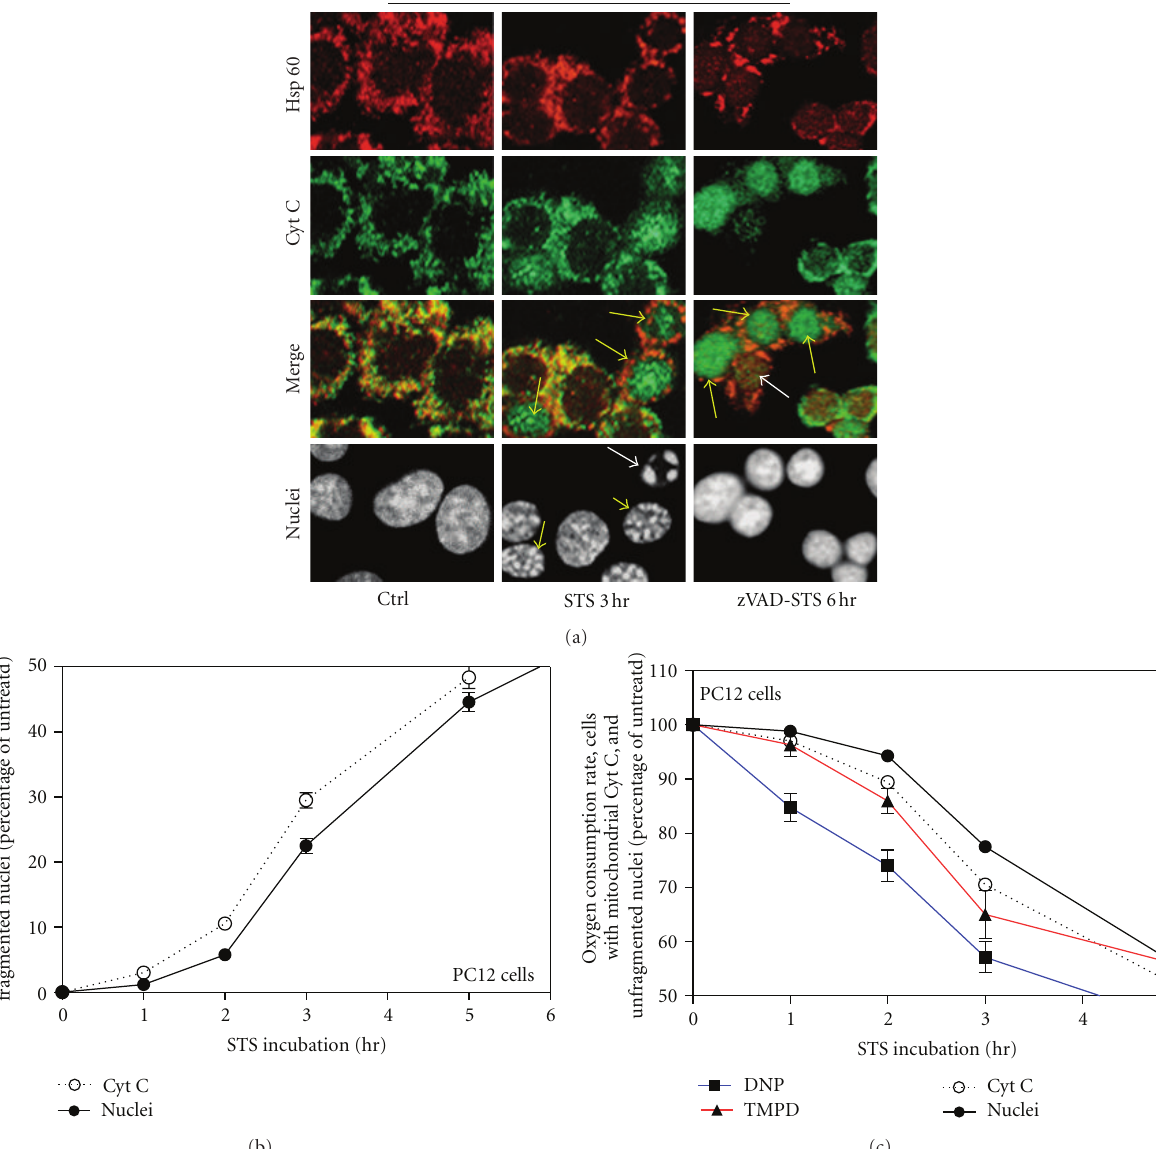
Figure 2: Cytochrome c release and nuclear apoptosis in STS-treated PC12 cells. (a) Triple labeling confocal immunofluorescence microscopy of cells untreated (Ctrl), 2 μ M STS-treated for 3h (STS 3h), or 2 μ M STS-treated for 6h with 30min zVADfmk (100uM) pretreatment (zVAD-STS 6h). Pattern of Hsp60 (red), cytochrome c (green), merged patterns (yellow) and nuclear staining by SYTO-X (grey) of the same representative fields are shown. (b) Percentage of cytochrome c releasing and apoptotic PC12 cells treated with STS for the indicated time. Data calculated in 3 independent experiments for each time point. About 1000 cells were considered for each experiment at each time point. Some SE are small and are within the symbols. Note that the ordinate scale starts at 50%. (c) Comparison between data shown in Figure 2(b) but expressed as decrease of cells with mitochondrially localized cytochrome c and decrease of alive cells and data regarding decrease in respiration shown in Figure